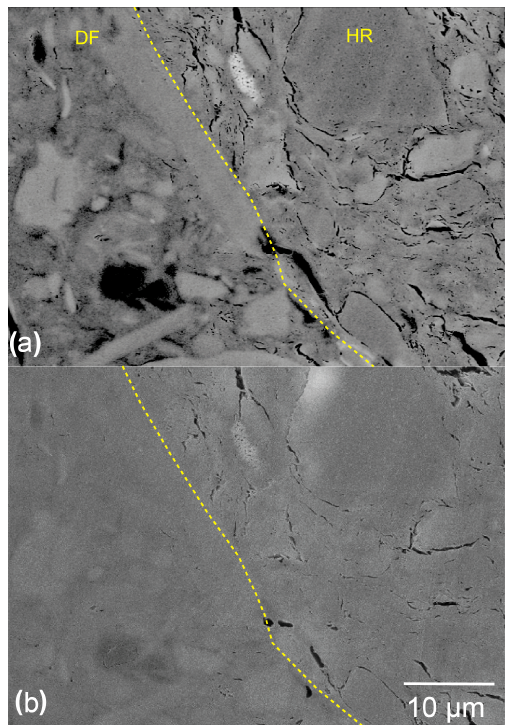
Figure 10. Details of Fig. 9b. Microstructures (ROI-1_COX- 10MPa) showing details of porosity in BSE–SEM micrograph (a) and SE2 SEM micrograph (b) . At the resolution of the SEM micrograph, the damaged fabric appears to be very low porous in comparison to the host rock. The dashed yellow line indicates the boundary between the damaged fabric (DF) and the host rock (HR).